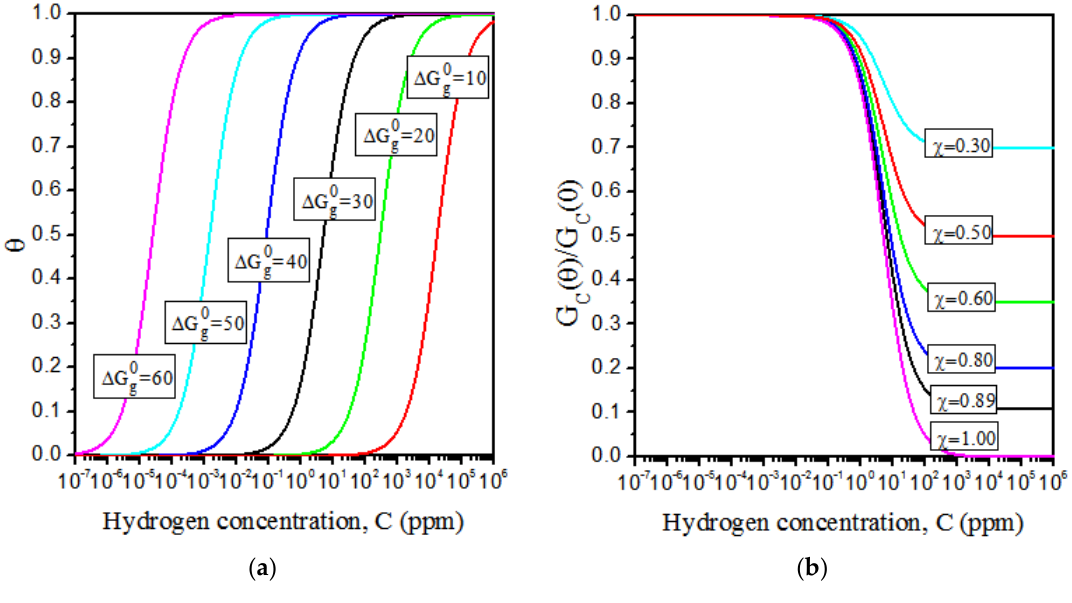
Figure 1. ( a ) The hydrogen coverage θ as a function of hydrogen concentration for a range of Gibbs free energy values of 10 kJ/mol to 60 kJ/mol; ( b ) hydrogen embrittlement parameter G C ( θ ) / G C ( 0 ) as a function of hydrogen concentration for a range of hydrogen damage factor χ values of 0.30 to 1.00 ( ∆ G 0 g = 30 kJ/mol ).